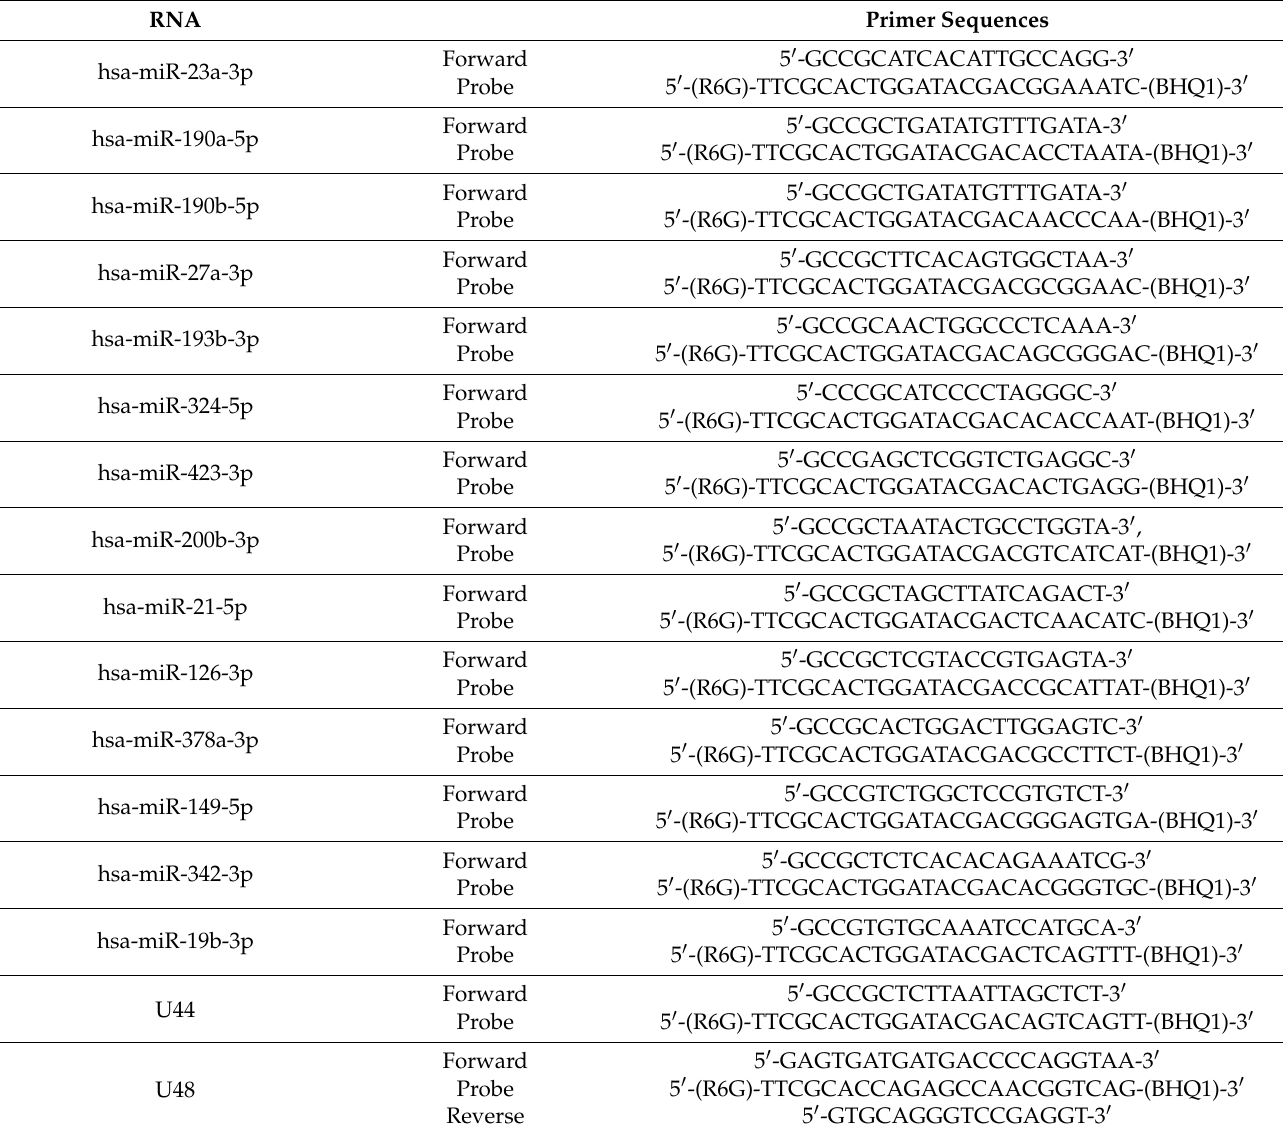
Table 2. Sequence of primers for RT-PCR of miRNAs. RNA Primer